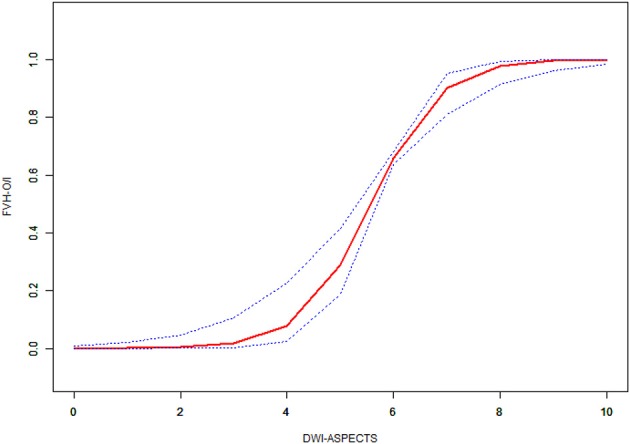
Non-linear association of the difference between DWI-ASPECTS with odds ratio of FVH outside DWI-positive area and FVH inside DWI-positive area by smoothing curve fitting.Outcome: FVH-O/I = FVH-DWI mismatch/FVH-DWI match. Exposure: DWI-ASPECTS.